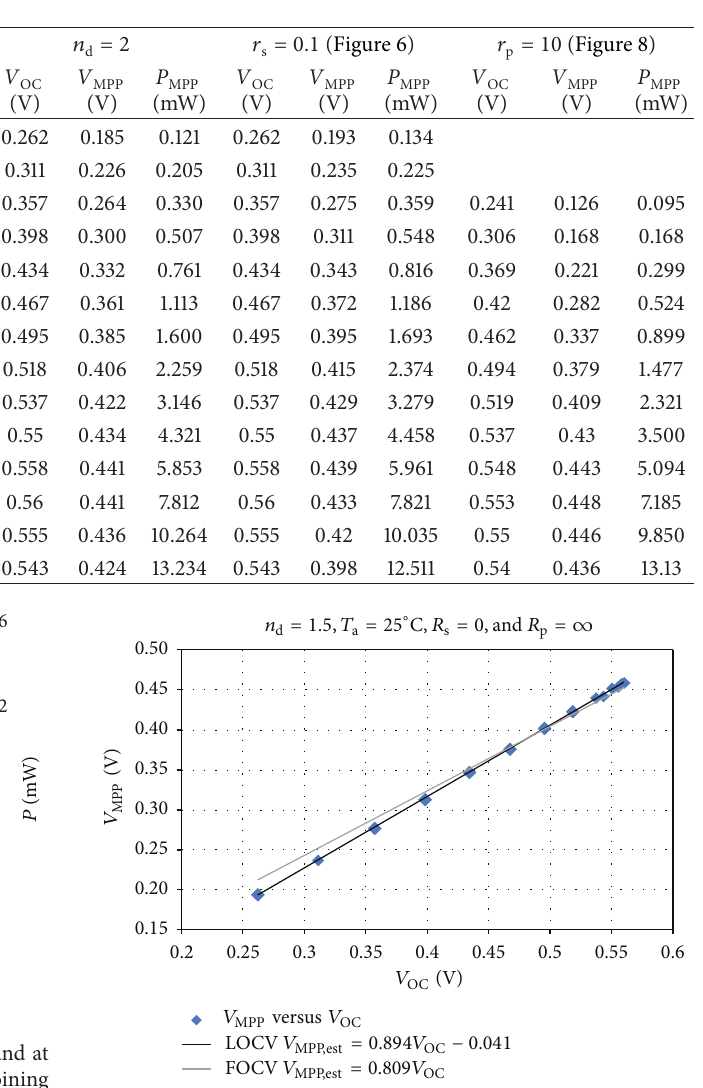
, V ; and P data at fourteen points of irradiance, logarithmically equally spaced, and for different values of the OC MPP MPP